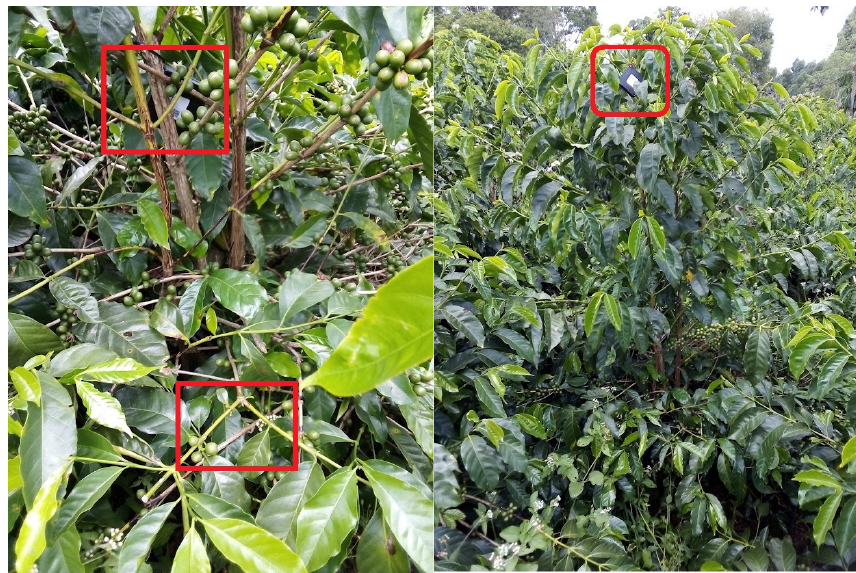
Figure 9. Installation of devices on Coffee